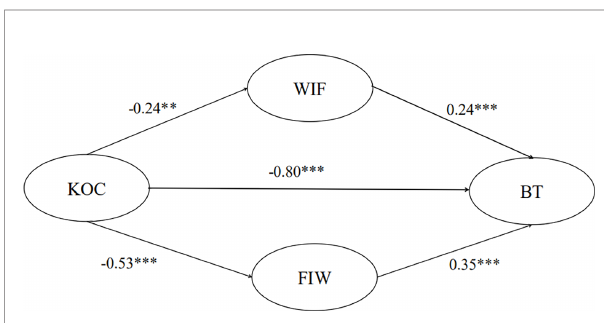
FIGURE 1 | Model of the relationship among kindergarten organizational climate, WIF, FIW, and teacher burnout. KOC, kindergarten organizational climate; TB, teacher burnout; WIF, work interfering with family; FIW, family interfering with work. ** p < 0.01, *** p <